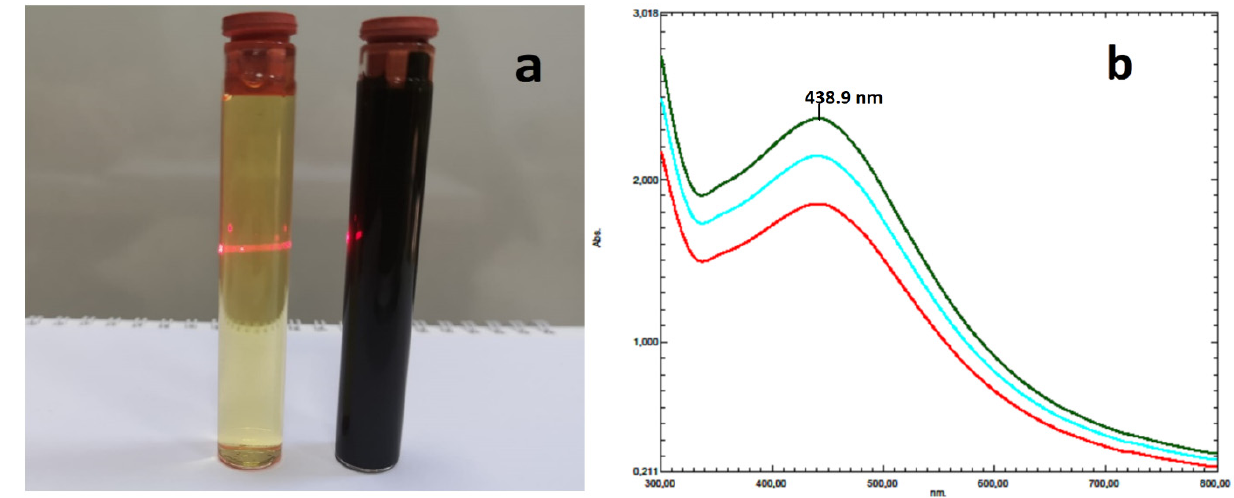
Figure 1. ( a ) Tyndall effect and visible laser beam path on colloidal AgNPs. ( b ) Time-dependent UV-Vis spectrum data of synthesized AgNPs.